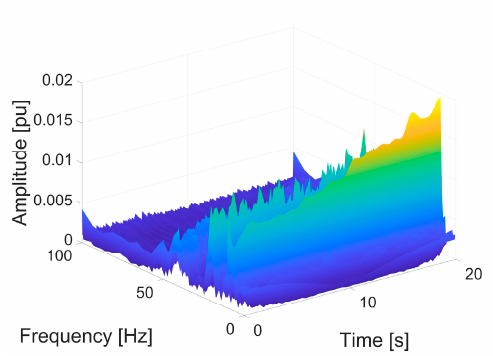
i ′ spectrum in the frequency Figure 11. DC range (0–100) Hz and configuration CB.